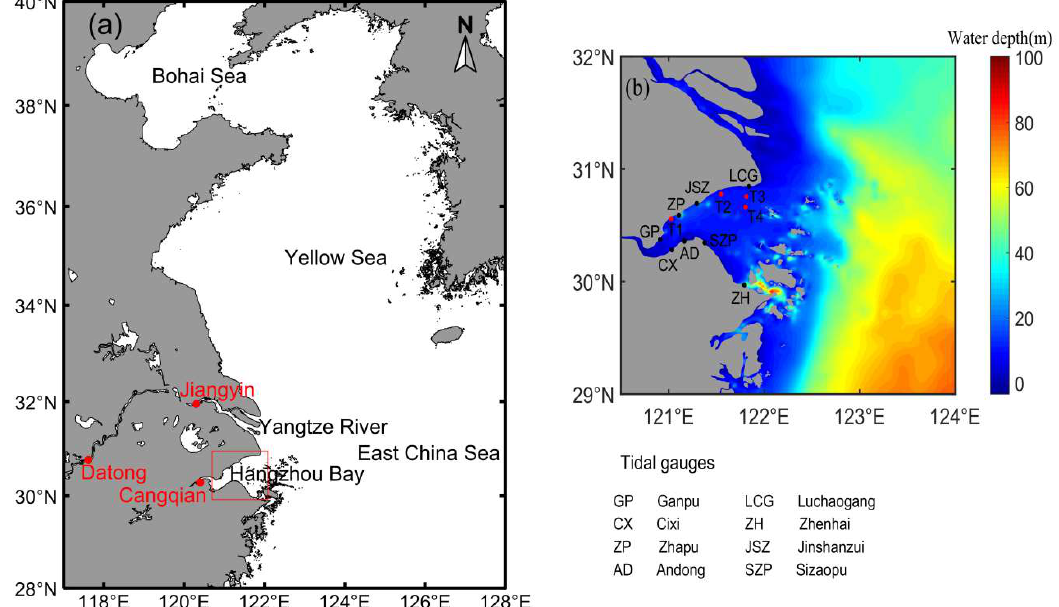
Figure 1. ( a ) Location map of the study area showing the large-scale Hangzhou Bay model of three stations of Datong, Jiangyin and Cangqian. ( b ) Domain of the Hangzhou Bay model showing the depth and location of the tidal gauges for the tide level (black dots) and tidal current (red dots).